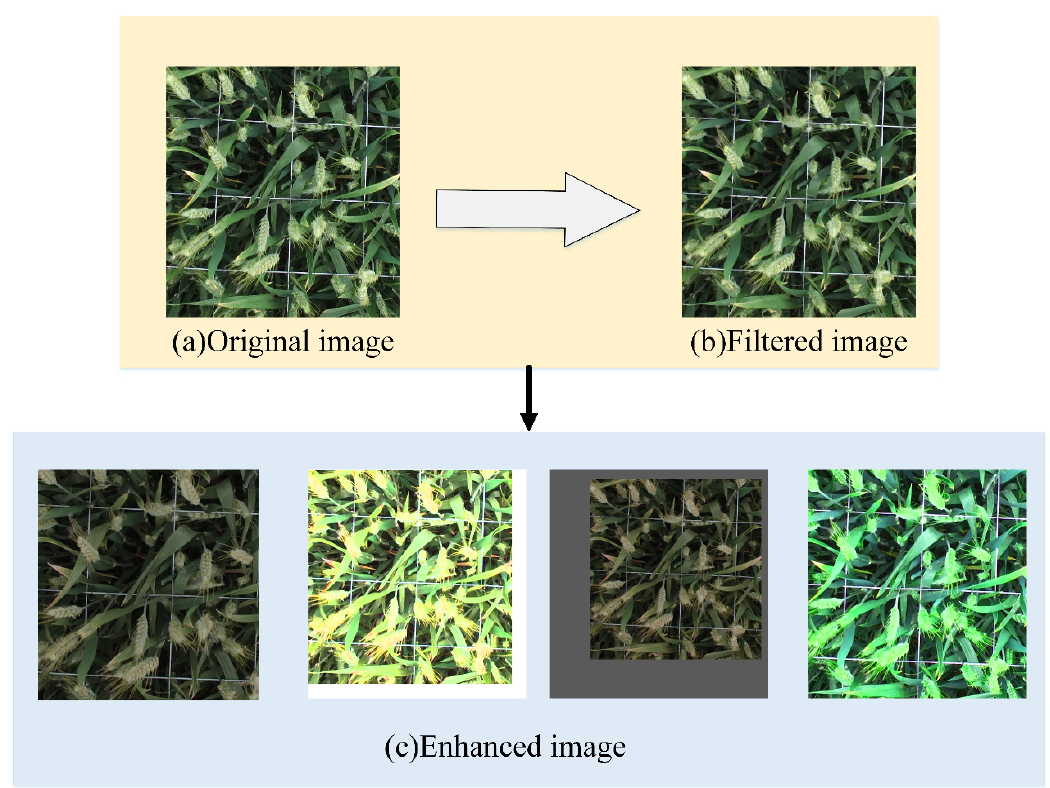
Figure 4. Image denoising and data enhancement. (a) original image; (b) filtered image; (c) enhanced image.